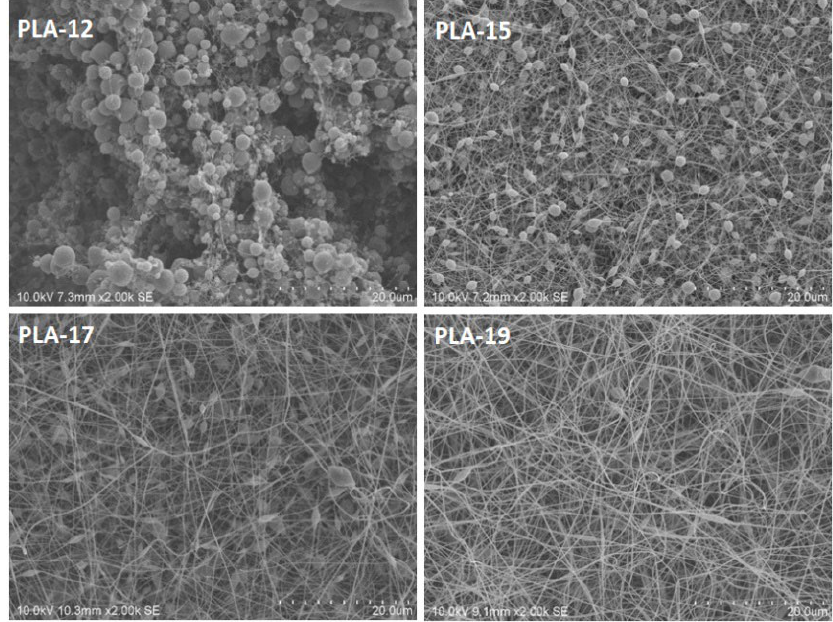
Figure 3. SEM images of pure PLA nanofibers with concentrations of 12, 15, 17, and 19% (scale — 20